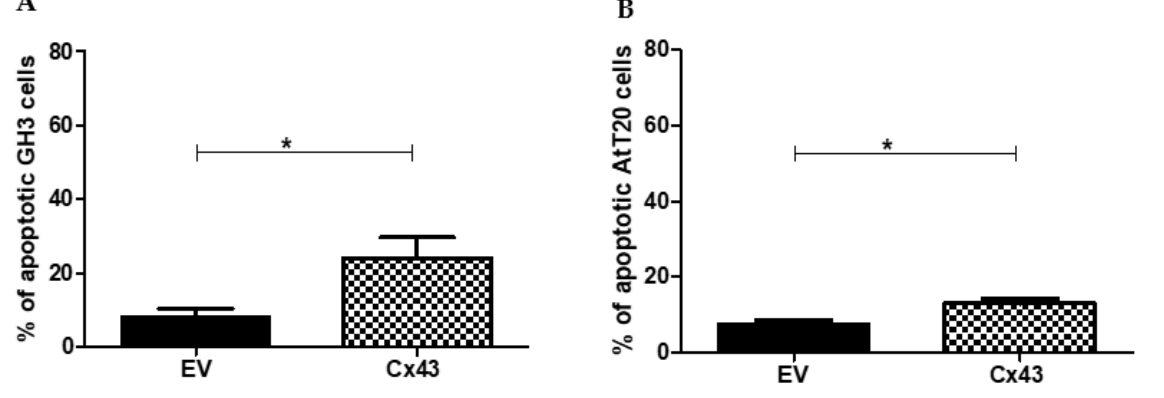
Figure 4. Effect of connexin 43 overexpression in the apoptosis of GH3 and AtT-20 cell lines. ( A )— Graphic representation of the percentage of apoptotic cells in GH3-EV and GH3-Cx43. ( B )—Graphic representation of the percentage of apoptotic cells in AtT-20-EV and AtT-20-Cx43. The data are presented as the mean ± SEM and are representative of at least three experiments that were performed in duplicate (analysis using Mann–Whitney U-tes.t, * p < 0.05).